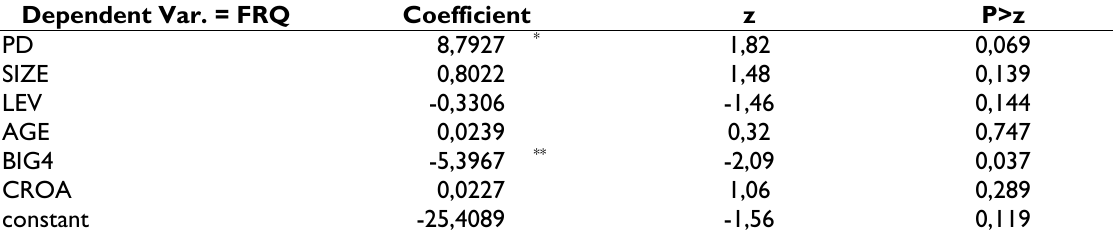
Table 6. The Effect of Financial Distress on Financial Reporting Quality Dependent Var. = FRQ